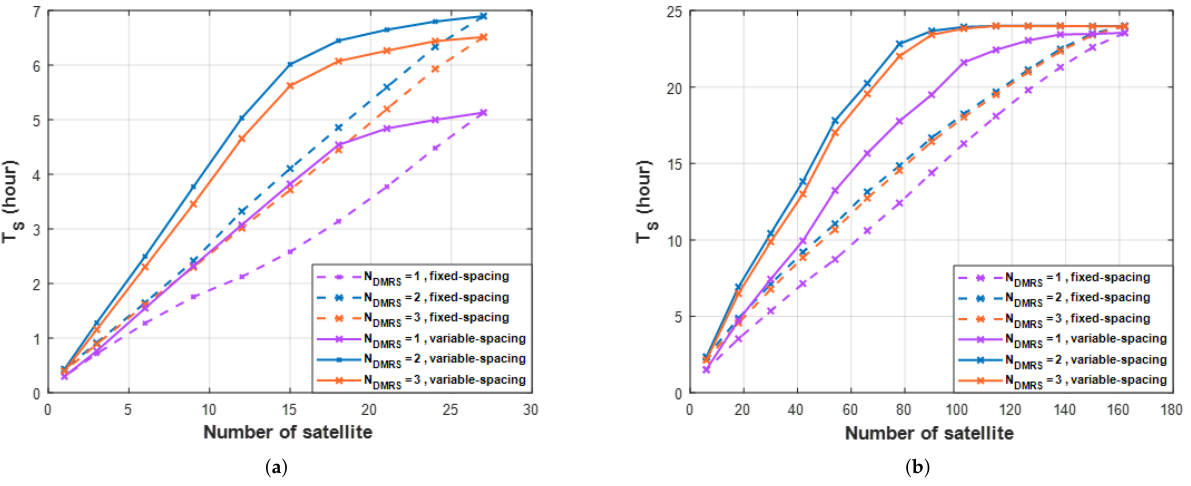
Figure 18. The per − day total service time for different numbers of DMRS symbols per slot. ( a ) one orbit, ( b ) six